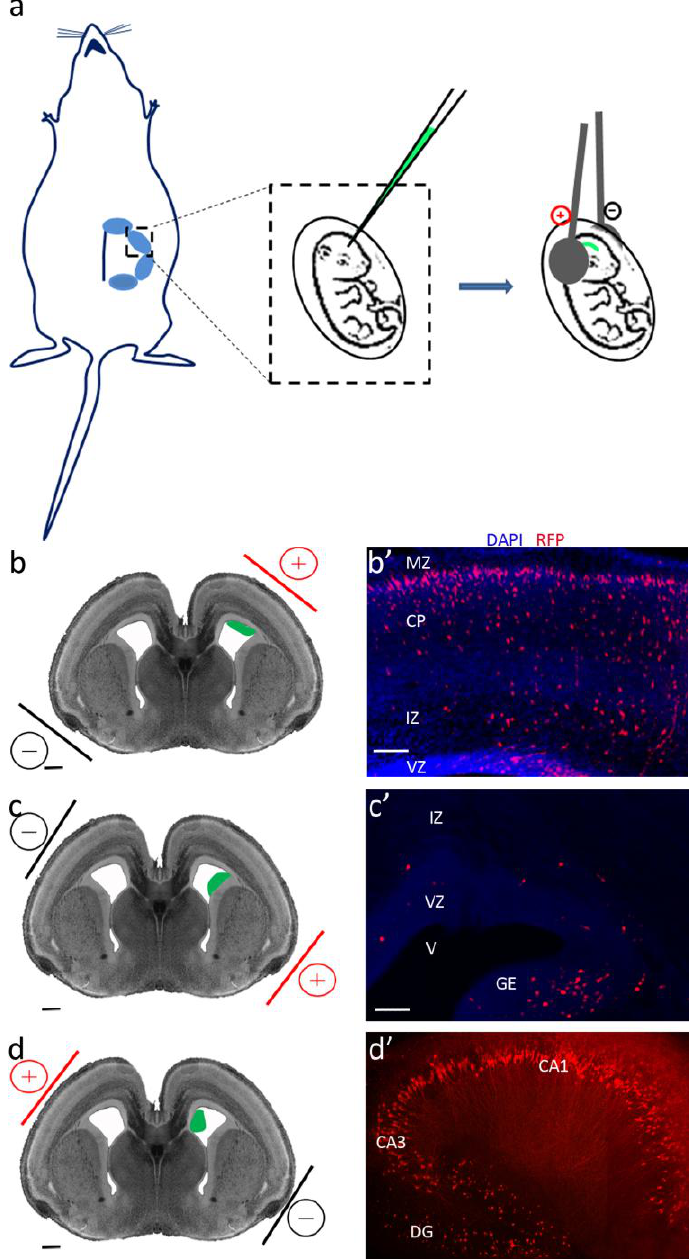
Figure 1. In utero electroporation enables spatial regulation of shRNA transfection. ( a ) Schematic representation of the in utero electroporation technique. ( b (cid:177) d ) The position of the positive pole of the electrode determines the cortical areas to be targeted. Targeting the (cid:89)(cid:72)(cid:81)(cid:87)(cid:85)(cid:76)(cid:70)(cid:88)(cid:79)(cid:68)(cid:85)(cid:3) (cid:93)(cid:82)(cid:81)(cid:72)(cid:3) (cid:82)(cid:73)(cid:3) (cid:87)(cid:75)(cid:72)(cid:3) (cid:71)(cid:82)(cid:85)(cid:86)(cid:68)(cid:79)(cid:3) (cid:87)(cid:72)(cid:79)(cid:72)(cid:81)(cid:70)(cid:72)(cid:83)(cid:75)(cid:68)(cid:79)(cid:82)(cid:81)(cid:3) (cid:11)(cid:69)(cid:12)(cid:3) (cid:79)(cid:68)(cid:69)(cid:72)(cid:79)(cid:86)(cid:3) (cid:70)(cid:82)(cid:85)(cid:87)(cid:76)(cid:70)(cid:68)(cid:79)(cid:3) (cid:83)(cid:85)(cid:82)(cid:77)(cid:72)(cid:70)(cid:87)(cid:76)(cid:82)(cid:81)(cid:3) (cid:81)(cid:72)(cid:88)(cid:85)(cid:82)(cid:81)(cid:86)(cid:3) (cid:11)(cid:69)(cid:182)(cid:3) (cid:82)(cid:88)(cid:85)(cid:3) unpublished data). Targeting the ganglionic eminences of the ventral telencephalon (c) labels (cid:70)(cid:82)(cid:85)(cid:87)(cid:76)(cid:70)(cid:68)(cid:79)(cid:3)(cid:76)(cid:81)(cid:87)(cid:72)(cid:85)(cid:81)(cid:72)(cid:88)(cid:85)(cid:82)(cid:81)(cid:86)(cid:3)(cid:11)(cid:70)(cid:182)(cid:3)(cid:82)(cid:88)(cid:85)(cid:3)(cid:88)(cid:81)(cid:83)(cid:88)(cid:69)(cid:79)(cid:76)(cid:86)(cid:75)(cid:72)(cid:71)(cid:3)(cid:71)(cid:68)(cid:87)(cid:68)(cid:12)(cid:17)(cid:3)(cid:55)(cid:68)(cid:85)(cid:74)(cid:72)(cid:87)(cid:76)(cid:81)(cid:74)(cid:3)(cid:87)(cid:75)(cid:72)(cid:3)(cid:75)(cid:76)(cid:83)(cid:83)(cid:82)(cid:70)(cid:68)(cid:80)(cid:83)(cid:68)(cid:79)(cid:3)(cid:81)(cid:72)(cid:88)(cid:85)(cid:82)(cid:72)(cid:83)(cid:76)(cid:87)(cid:75)(cid:72)(cid:79)(cid:76)(cid:88)(cid:80)(cid:3) (cid:11)(cid:71)(cid:12)(cid:3) (cid:79)(cid:68)(cid:69)(cid:72)(cid:79)(cid:86)(cid:3) (cid:75)(cid:76)(cid:83)(cid:83)(cid:82)(cid:70)(cid:68)(cid:80)(cid:83)(cid:68)(cid:79)(cid:3) (cid:81)(cid:72)(cid:88)(cid:85)(cid:82)(cid:81)(cid:86)(cid:3) (cid:11)(cid:71)(cid:182)(cid:12)(cid:30)(cid:3) (cid:76)(cid:80)(cid:68)(cid:74)(cid:72)(cid:3) (cid:68)(cid:71)(cid:82)(cid:83)(cid:87)(cid:72)(cid:71)(cid:3) (cid:90)(cid:76)(cid:87)(cid:75)(cid:3) (cid:83)(cid:72)(cid:85)(cid:80)(cid:76)(cid:86)(cid:86)(cid:76)(cid:82)(cid:81)(cid:3) (cid:73)(cid:85)(cid:82)(cid:80)(cid:3) [71]). Embryos were electroporated in utero at E14.5 (b (cid:177)(cid:71)(cid:30)(cid:3)(cid:86)(cid:70)(cid:68)(cid:79)(cid:72)(cid:3)(cid:69)(cid:68)(cid:85)(cid:29)(cid:3)(cid:21)(cid:24)(cid:19)(cid:3)(cid:151)(cid:80)(cid:12)(cid:3)(cid:68)(cid:81)(cid:71)(cid:3)(cid:75)(cid:68)(cid:85)(cid:89)(cid:72)(cid:86)(cid:87)(cid:72)(cid:71)(cid:3)(cid:68)(cid:87)(cid:3)(cid:40)(cid:20)(cid:27)(cid:17)(cid:24)(cid:3)(cid:11)(cid:69)(cid:182)(cid:177)(cid:70)(cid:182)(cid:30)(cid:3) scale bar: 100 µm) or P15. DAPI, 4',6-Diamidino-2-phenylindole dihydrochloride; RFP, red fluorescent protein; CP, cortical plate; DG, dentate gyrus; GE, ganglionic eminences; IZ, intermediate zone; MZ, marginal zone; V, ventricle; VZ, ventricular